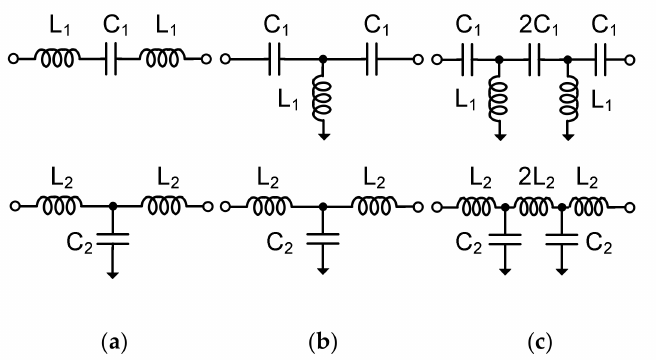
Figure 3. Schematics of ( a ) the SPDT switch, and ( b ) the DPDT switch.